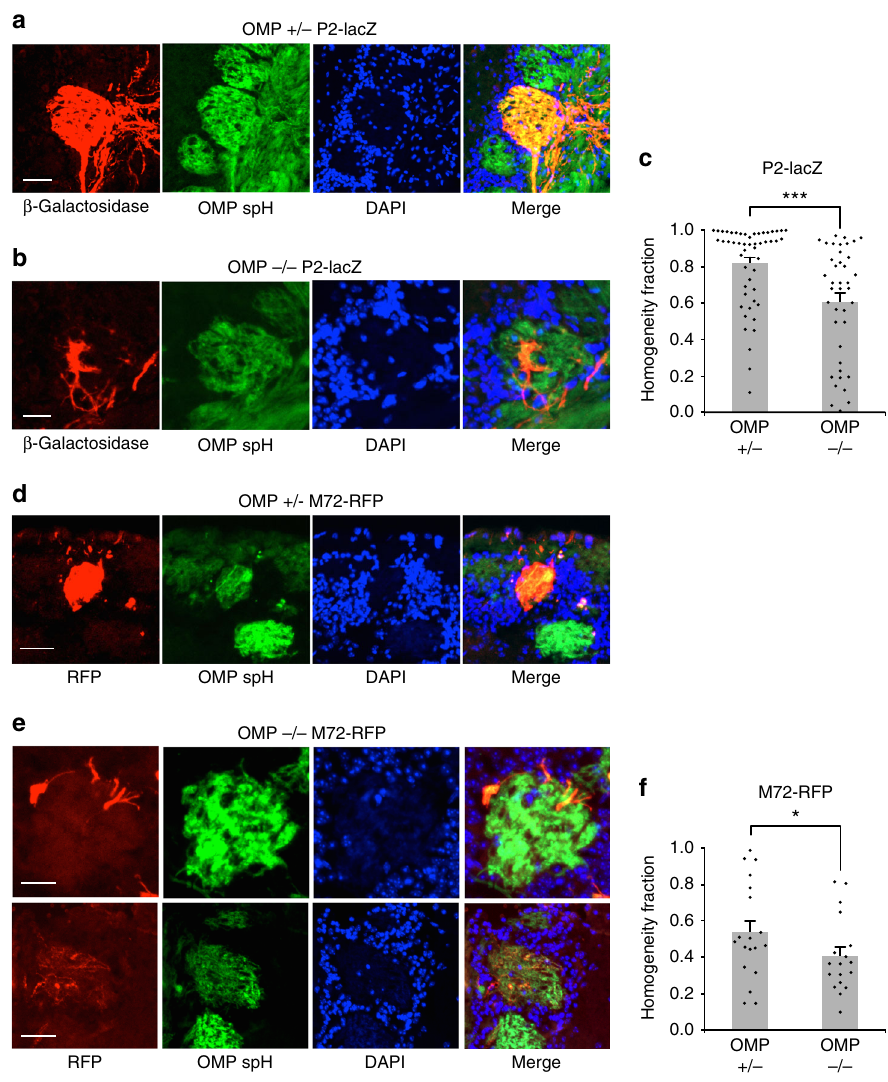
Fig. 4 Anatomical glomerular heterogeneity in OMP – / – mice. a Example homogeneous glomerulus in a P2-lacZ OMP + / – mouse. P2-positive OSN axons labeled with β -Gal (red), SpH-positive OSN axons (green) and glomerular outline by DAPI-stained nuclei of juxtaglomerular cells (blue). Note the high overlap between the red and green pixels in the merged image. Scale bar, 50 μ m. b Example heterogeneous glomerulus in a P2-lacZ OMP – / – mouse. P2- positive OSN axons labeled with β -Gal (red) do not overlap entirely with SpH-positive OSN axons (green) and only partially fi ll the glomerulus, outlined by DAPI-stained nuclei of juxtaglomerular cells (blue). Scale bar, 50 μ m. c Quanti fi cation of glomerular homogeneity (P2-lacZ) in the OMP + / – versus OMP – / – mice. Homogeneity fraction: 0.82 ± 0.03 (mean ± SEM, n = 52 glomeruli) in OMP + / – mice, and 0.61 ± 0.05 (mean ± SEM, n = 40 glomeruli) in OMP – / – animals. Scale bar, 50 μ m. d , e Same as ( a ) and ( b ) an M72-RFP example glomerulus in the OMP + / – and OMP – / – genetic backgrounds. Scale bar, top 25 μ m, bottom 40 μ m. f Quanti fi cation of glomerular homogeneity in M72-RFP OMP + / – versus OMP – / – mice. Homogeneity fraction: 0.54 ± 0.06 (mean± SEM, n = 19 glomeruli) in OMP + / – mice, and 0.41 ± 0.05 (mean± SEM, n = 18 glomeruli) in OMP – / – animals; *p < 0.05, *** p < 0.001, Kolmogorov – Smirnov duplicates of P2 glomeruli in both the OMP – / – and OMP + / –